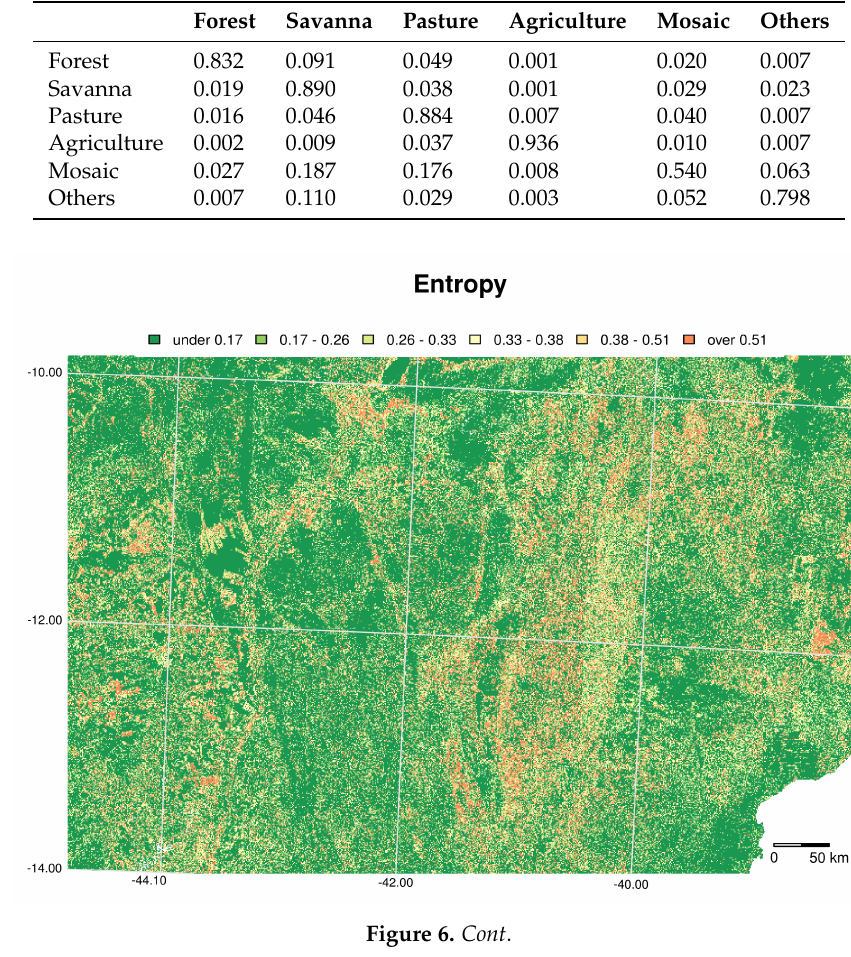
Figure 5. Some indexes of the descriptive analysis of sequences. Table 2. Rates of transition between land use/cover categories.